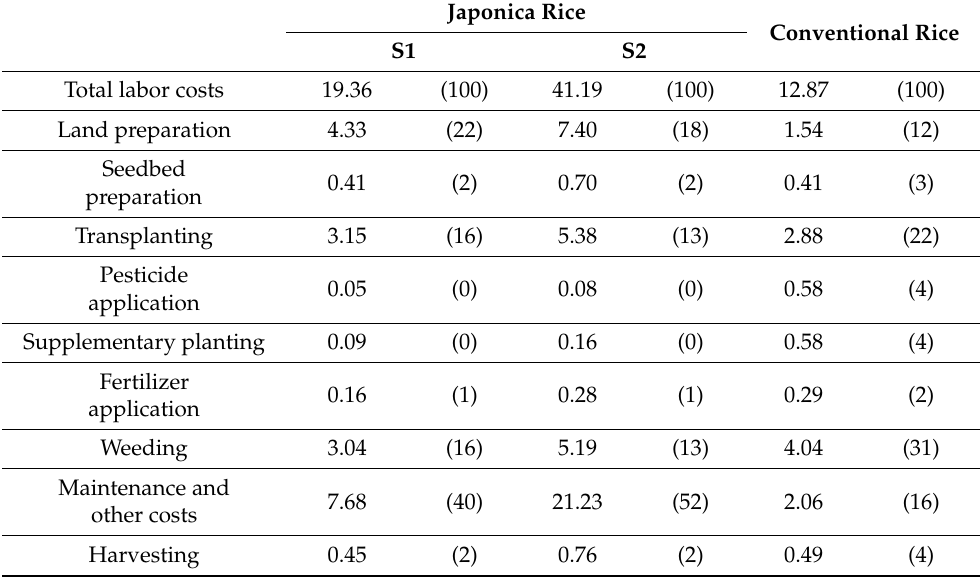
Table 4. Comparison of labor costs between japonica rice and conventional rice (unit: